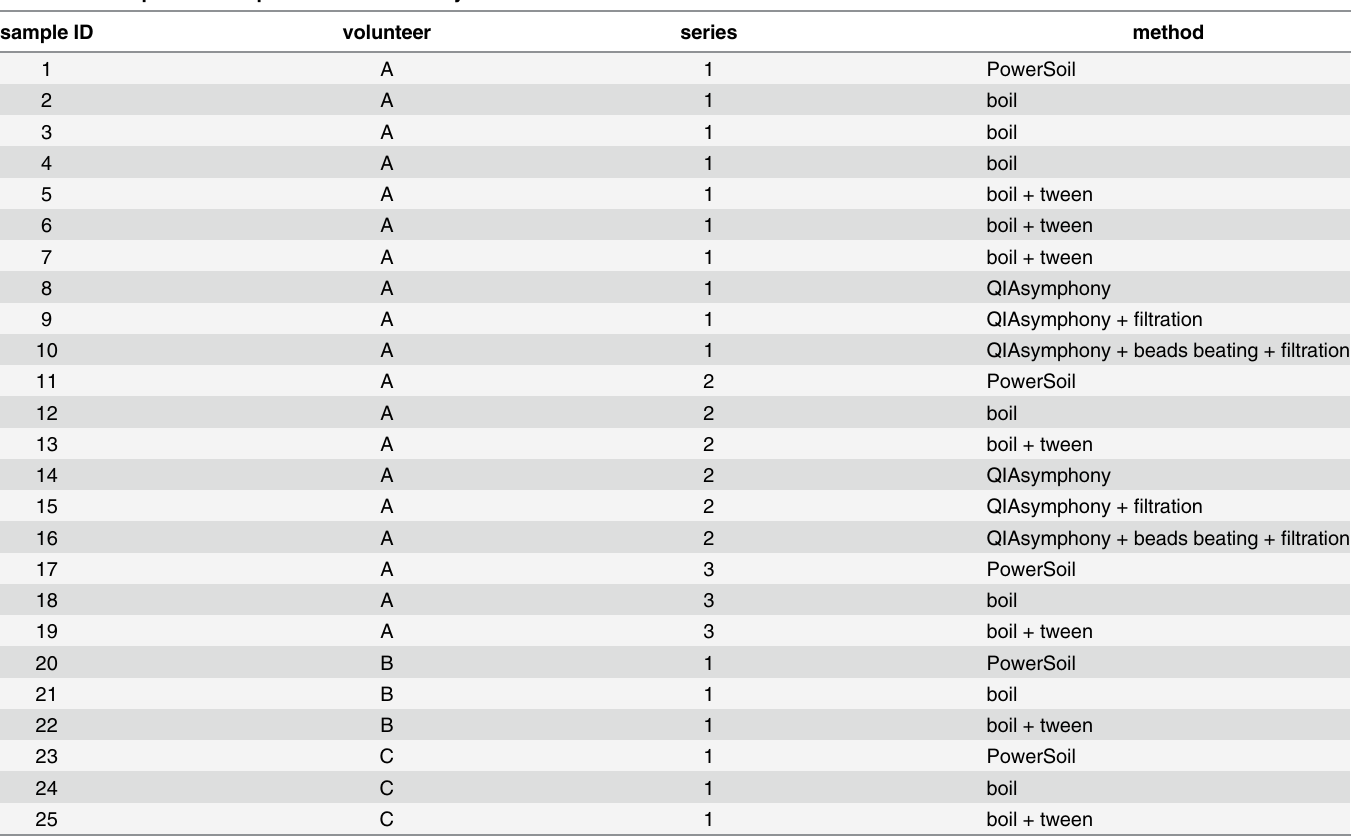
Table 1. Description of samples used in this